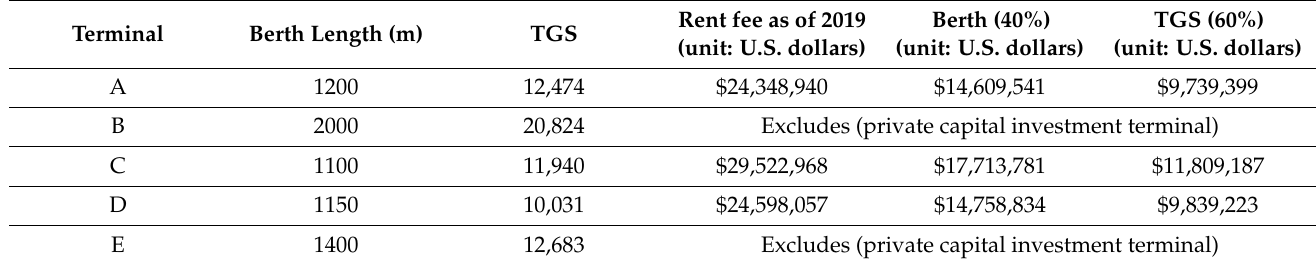
Table 2. Standard rent fee per terminal in Busan New